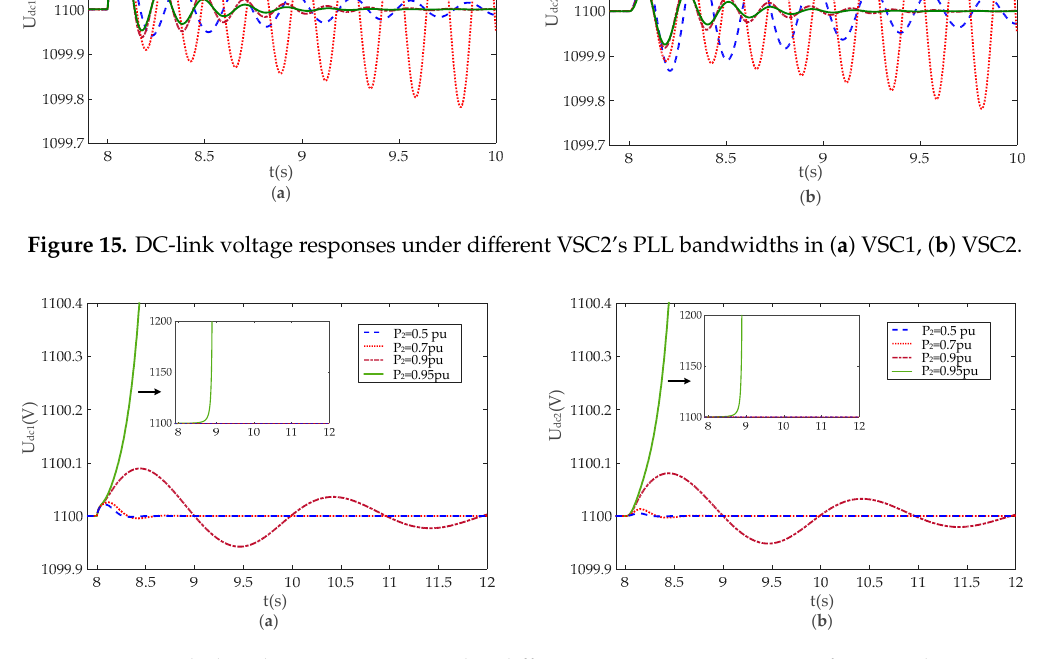
Figure 16. DC ‐ link voltage responses under different VSC2’ power outputs for open ‐ loop AVC Figure 16. DC-link voltage responses under di ff erent VSC2’ power outputs for open-loop AVC conditions in ( a ) VSC1, ( b ) VSC2. conditions in ( a ) VSC1, ( b )